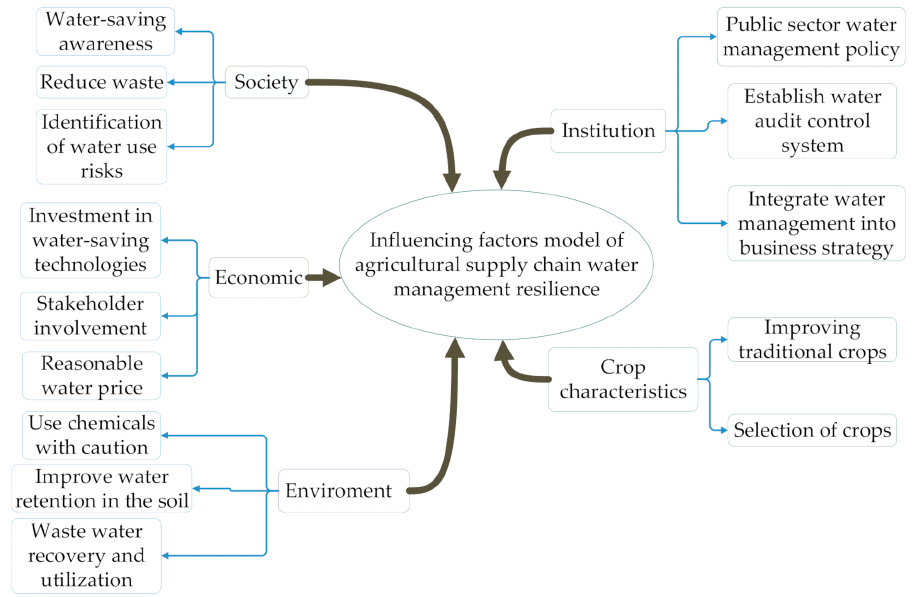
Figure 4. A model of factors found to influence agricultural supply chain resilience to